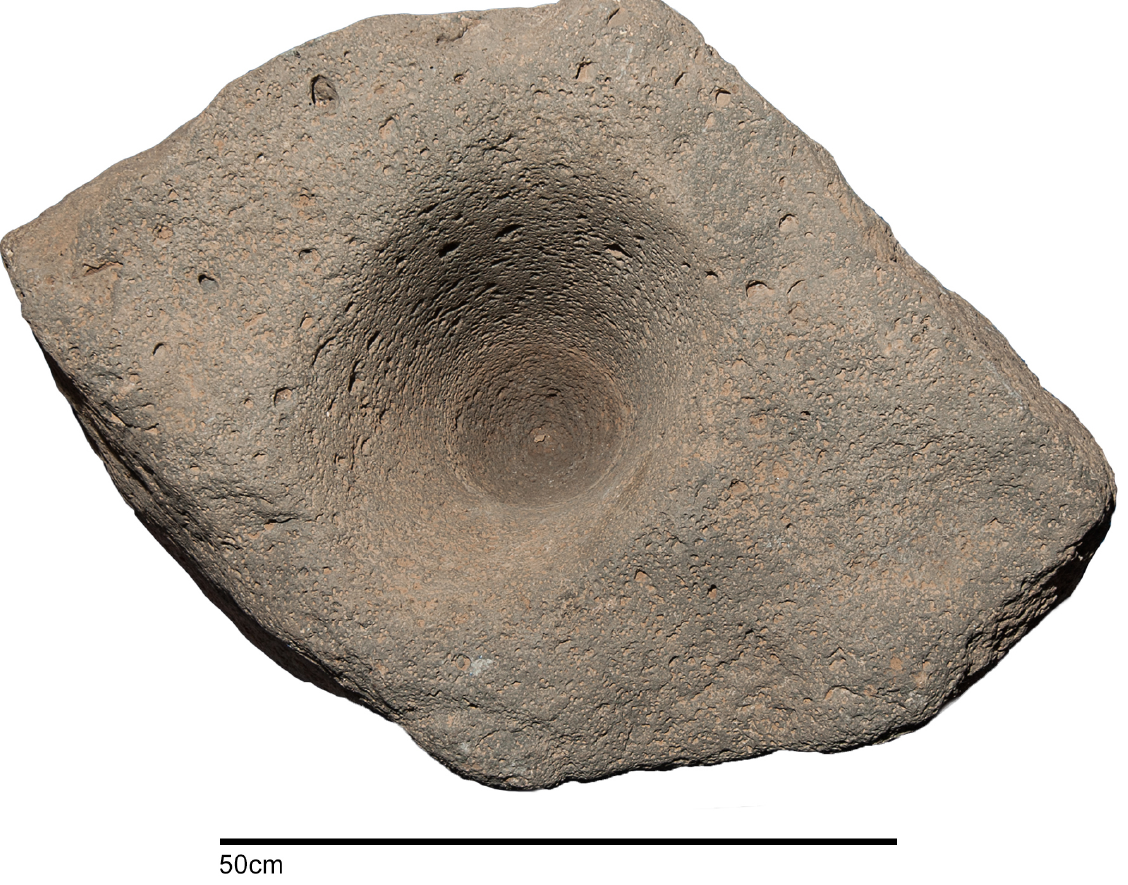
Figure 9: Complete boulder mortar recovered from the floor surface of Structure 2, late Natufian phase of Shubayqa 1 (see also Figure